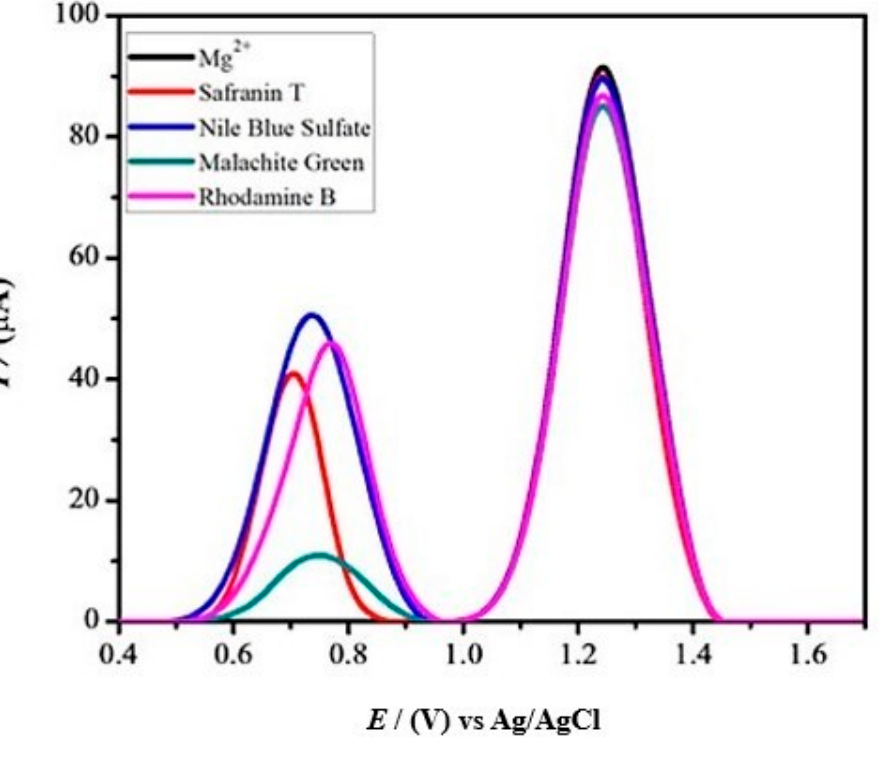
Figure 8. Differential pulse voltammograms for 90 µ M IBP in the presence of 1 mM different interfering agents.